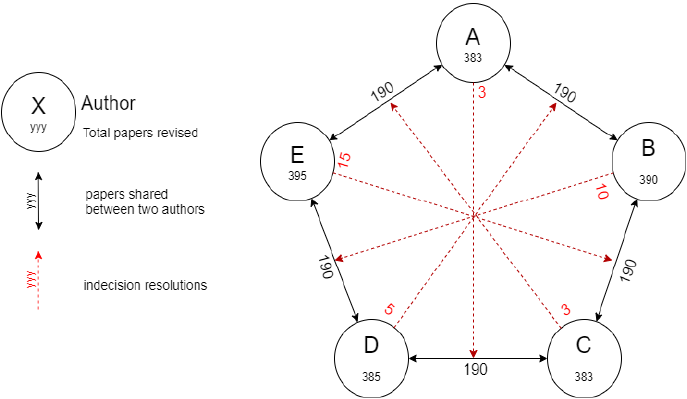
Figure 2. Papers review process diagram.